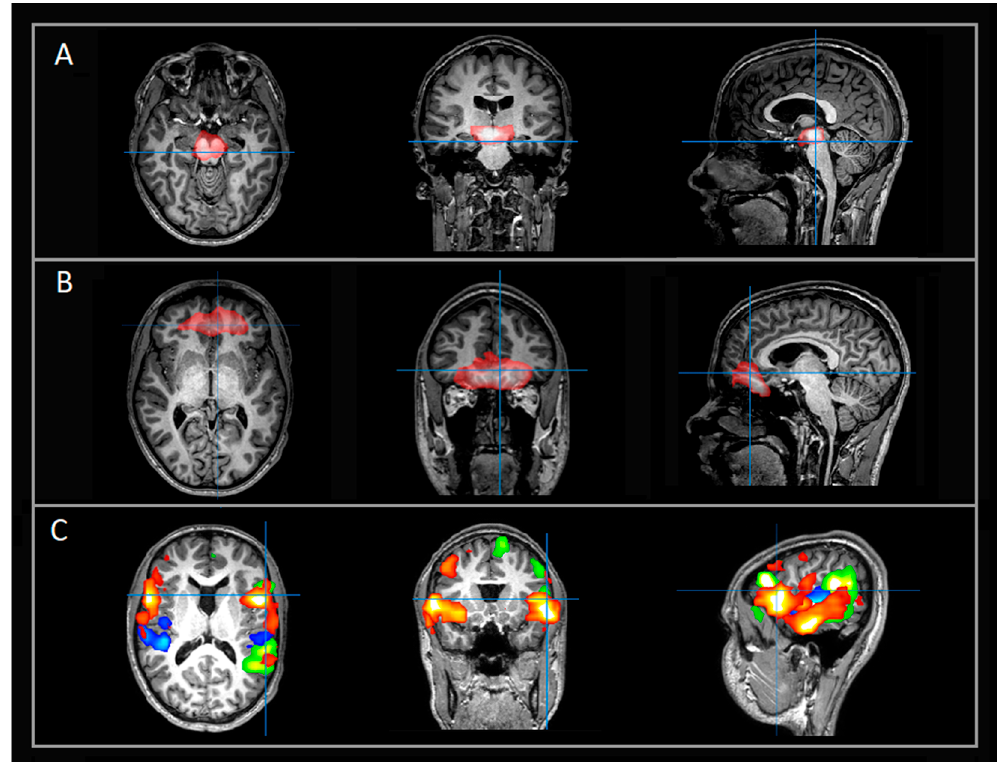
Figure 2. Select rs-fMRI networks in patient (case–control) evaluated for possible seizure focus (not detected, otherwise typical networks). All images are in radiological orientation. The indicated networks are overlaid on T1-weighted images in axial, coronal, and sagittal views. ( A ) Example of typical subcortical and brainstem networks; ( B ) Additional examples of typical networks extending over bilateral vmPFC region; ( C ) Typical language networks. Rows A and B, red color denotes BOLD activation. Row C, each color denotes a separate language network. Abbreviations: rs-fMRI = resting state functional magnetic imaging; vmPFC = ventromedial prefrontal cortex.